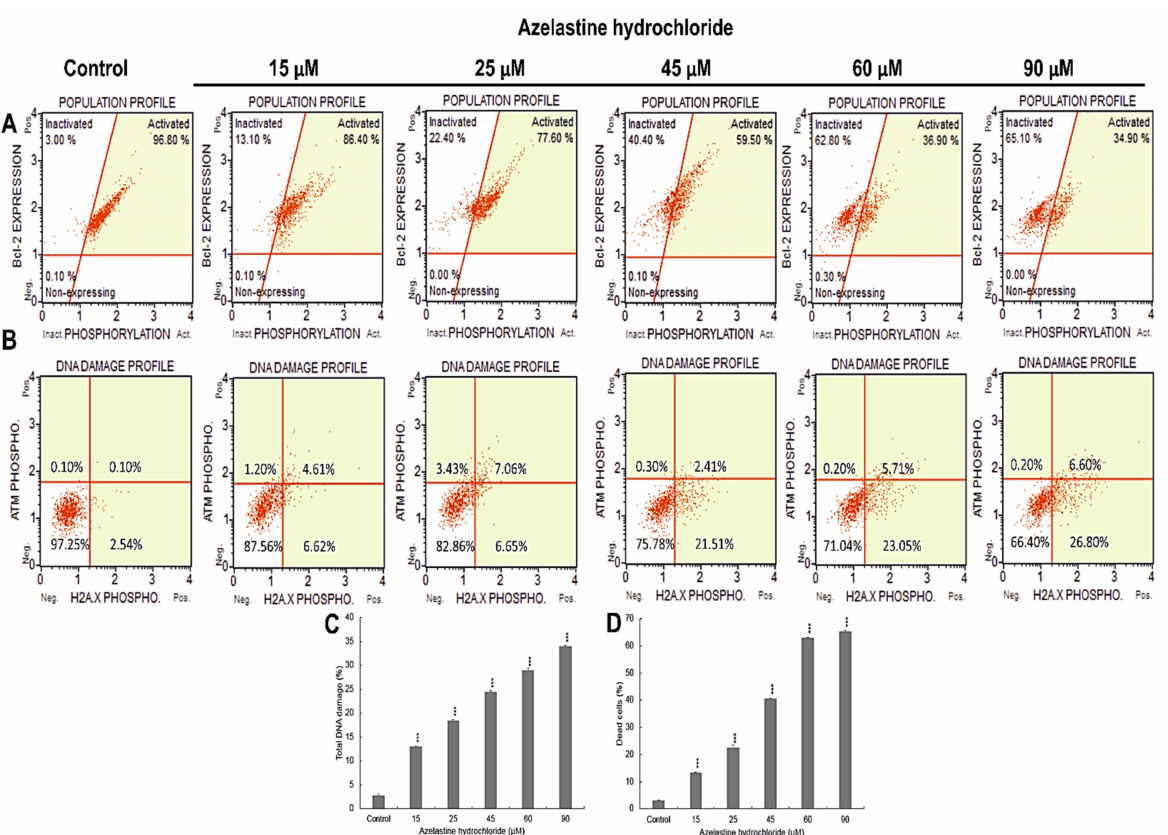
Figure 3. Bcl-2 protein inactivation and DNA damage demonstrated in cells exposed to 48 h action of azelastine hydrochloride. ( A ) Cells expressing Bcl-2 are clustered in the top two quadrants of the dot plot (inactivated and activated). Over 60% are dephosphorylated after treatment with azelastine at 60 µ M and 90 µ M, confirming inactivation of the Bcl-2 signaling pathway. ( B ) Azelastine at concentrations of 15–90 µ M generates DNA damage that induces DNA repair mechanisms such as γ H2AX. ( C ) Azelastine concentration-dependent percentage of cells with double-stranded DNA damage and ( D ) percentage of cells with Bcl-2 protein inactivation. Data representative of three parallel experiments correspond to mean values ± standard error (SE). Differences were statistically confirmed at: *** p <